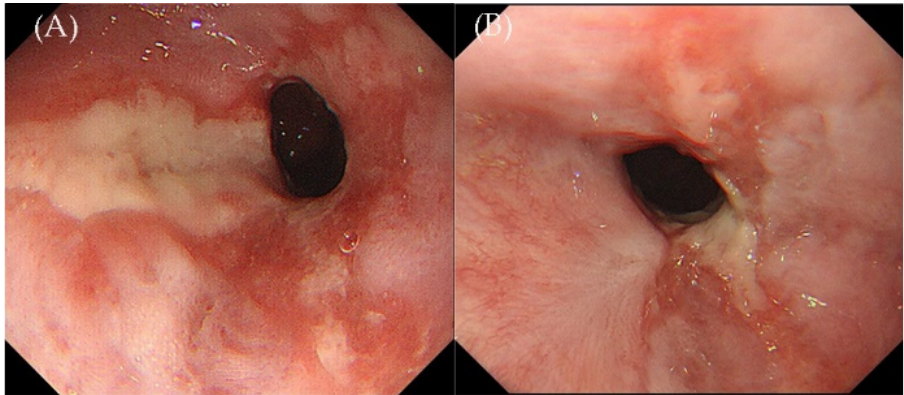
Figure 1. From left to right: ( A ) Gastroscopy from the outpatient department in our hospital on 2 September 2021. ( B ) Two months later, gastroscopy was performed in our hospital on 25 November 2021.